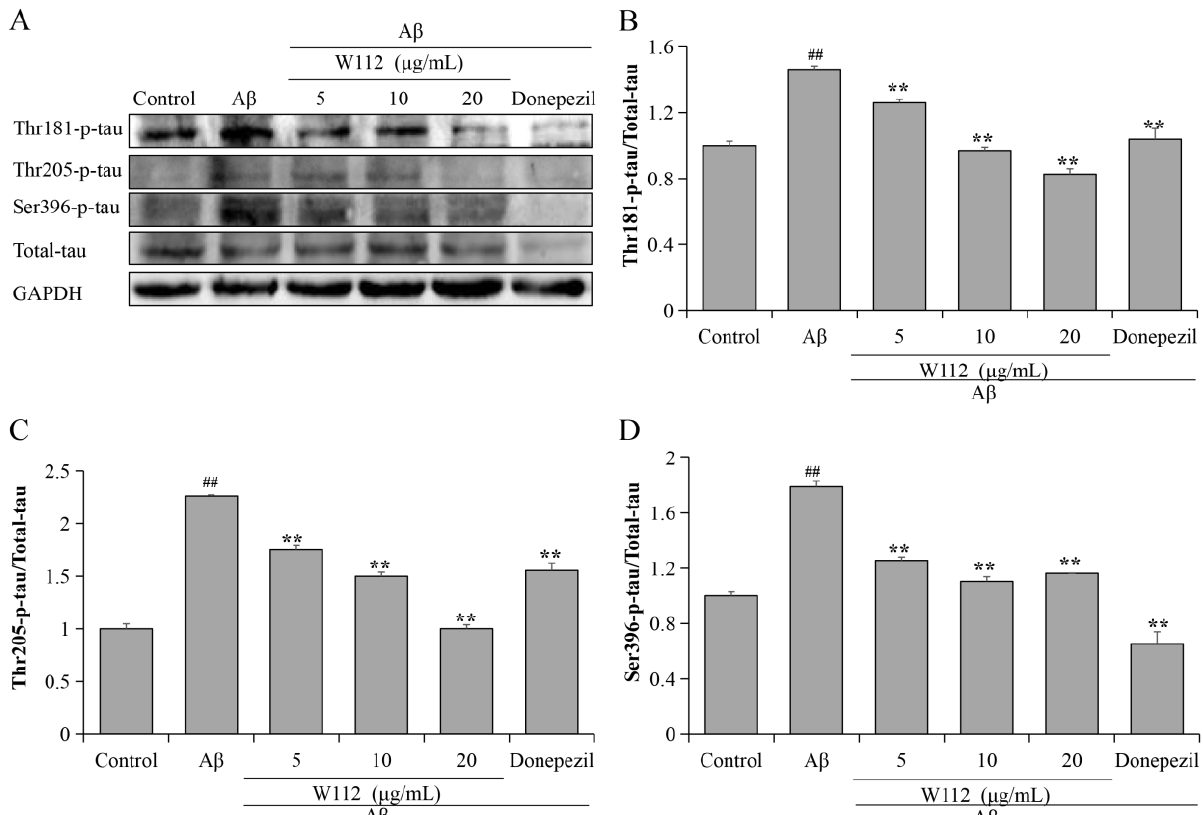
Figure 3. W112 prevented tau pathology in Aβ 25 – 35 -induced PC12 cells. ( A – D ) The protein levels of phosphorylated tau at thr181, thr205, and Ser396 sites in PC12 cells were measured by Western blot. n = 3. ## p < 0.01 vs. the control group; ** p < 0.01 vs. the model group.